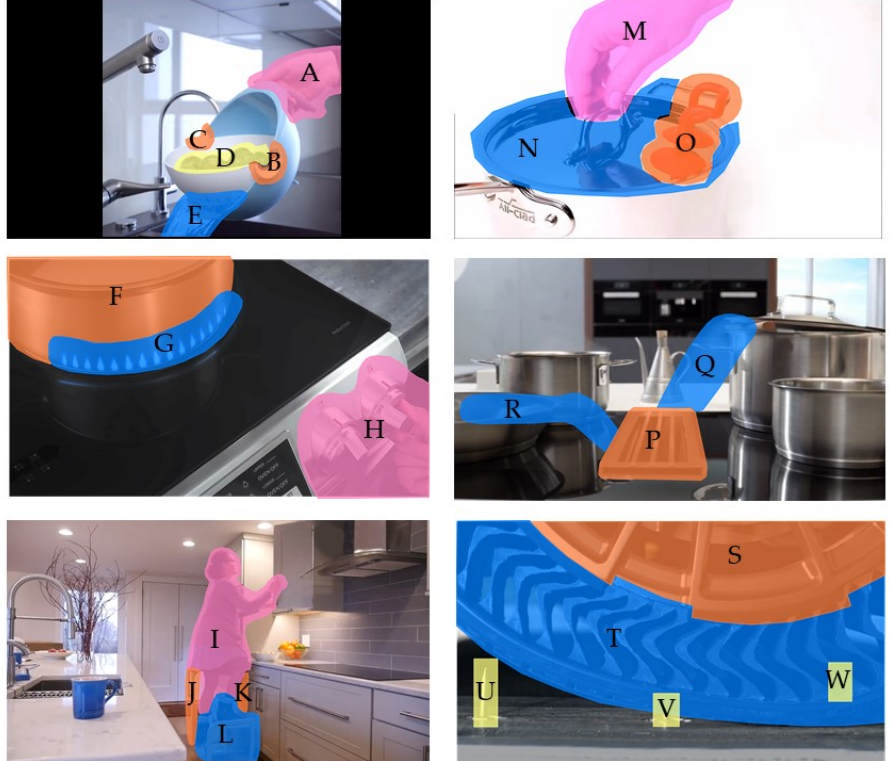
Figure 3. Areas of Interest studied for each product.